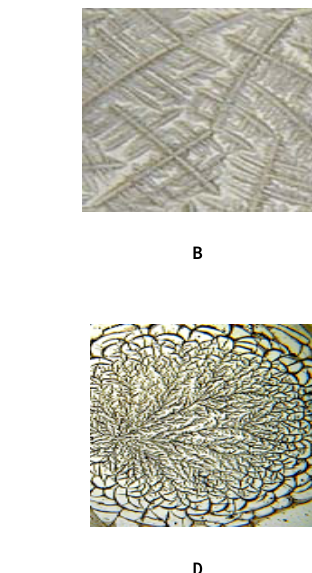
FIGURE 2 . Structural elements of the bio-liquids. (A) System of cracks and concretions, (B) dendrites, (C) inclusions, (D)